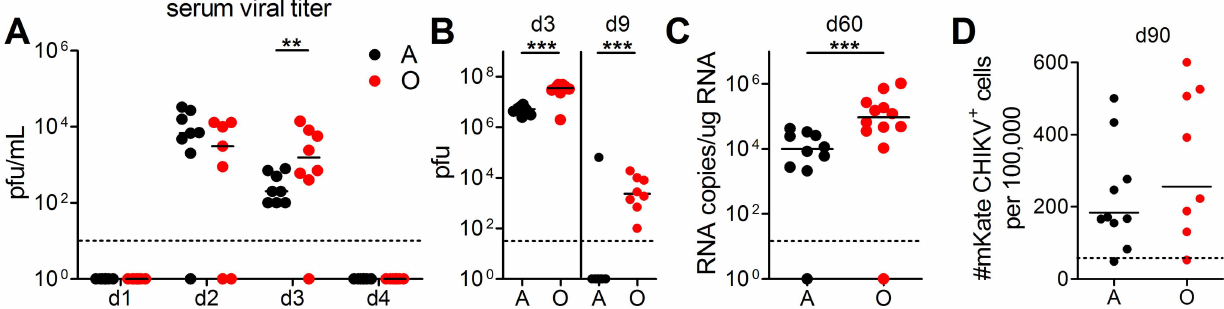
Fig 2. Prolonged CHIKV viremia with age and evidence of persistent infection. (A) Serum and (B) CHIKV-inoculated feet were harvested on indicateddays post-infection and assayed for viral titer by plaqueassay. (A) Serum viral titers on days 1–4 post-infection and (B) viral titer of CHIKV feet on days 3 and 9 post-infection ( n = 7–8 per group). (C) Genome copies of virus in CHIKV feet on day 60 post-infection ( n = 16–18 per group). (D) CHIKV-inoculated feet were harvested at day 90 p.i. and assayed for the presence of fluorescent infectious virus by co-culture on C6/36 insect cells (n = 8–10 per group). Dashed line indicateslimit of detectionfor all assays. Horizontal lines indicate the median. Statistical significancedetermined on log-transformed data by unpairedstudent’s t -test. * P < 0.05; ** P < 0.01; *** P < 0.001.